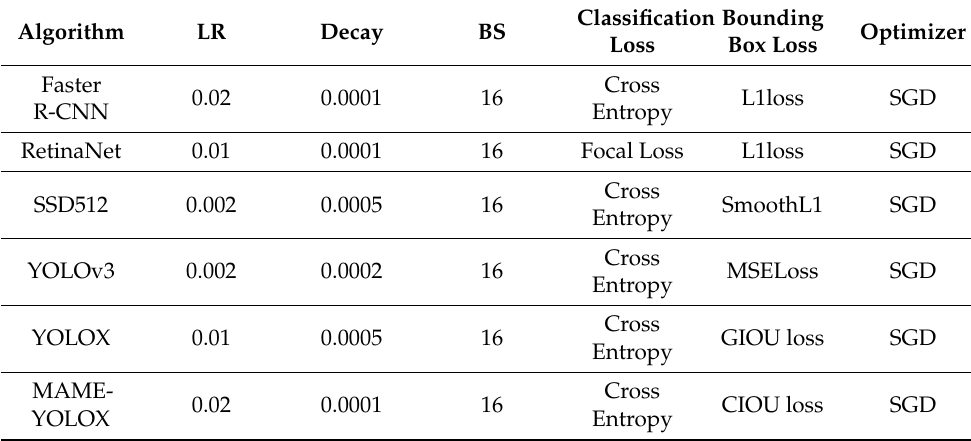
Table 1. The parameter settings of the competitive algorithms.